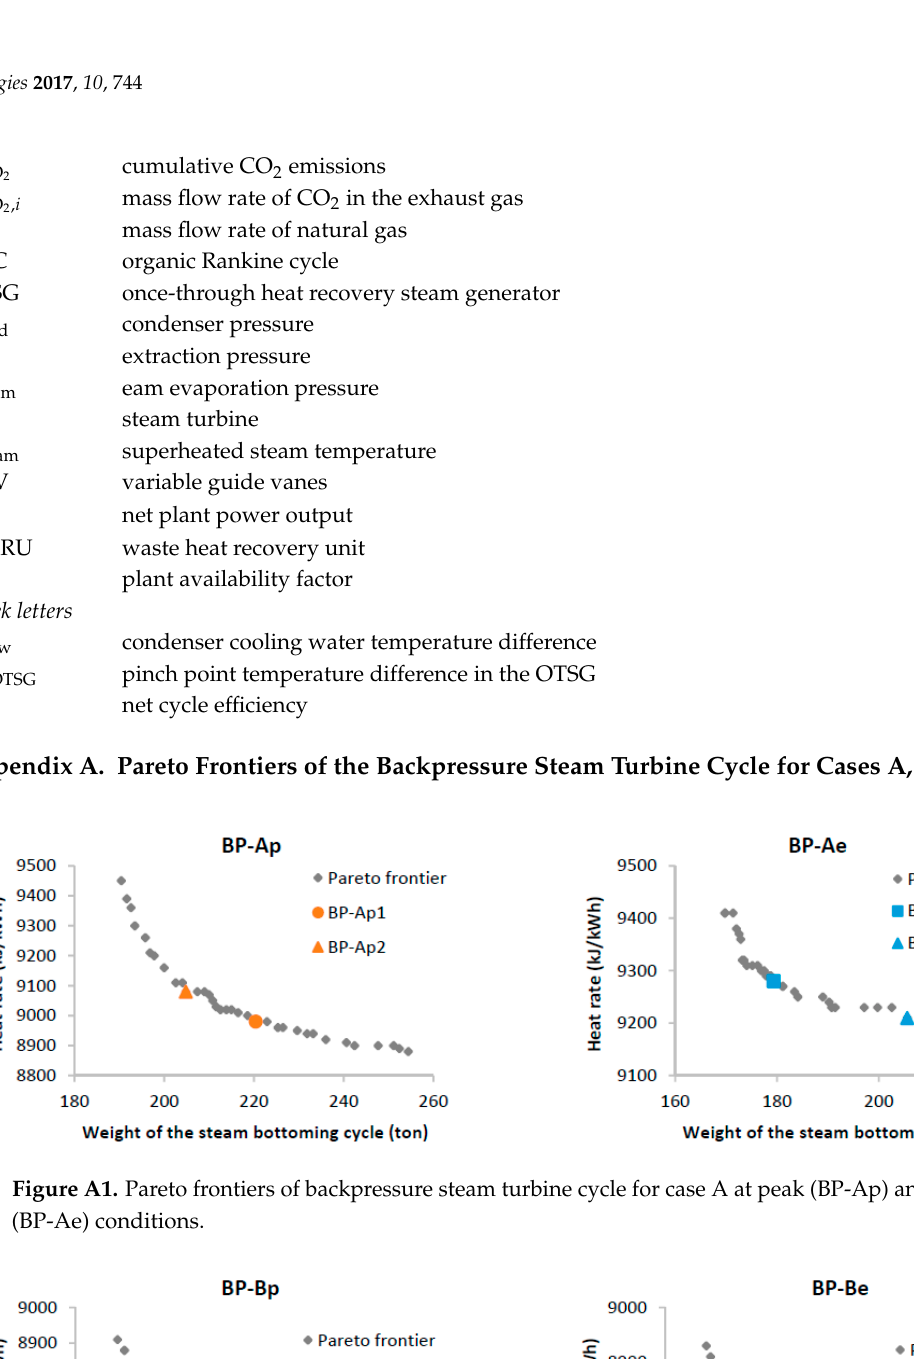
Figure A3. Pareto frontiers of backpressure steam turbine cycle for case C at peak (BP-Cp) and end- life (BP-Ce) conditions. Figure A4. Pareto frontiers of backpressure steam turbine cycle for case D at peak (BP-Dp) and end- life (BP-De) conditions. Appendix B. Pareto Frontiers of the Extraction Steam Turbine Cycle for Cases C and D Figure A5. Pareto frontiers of extraction steam turbine cycle for case C at peak (EX-Cp) and end-life (EX-Ce) conditions.